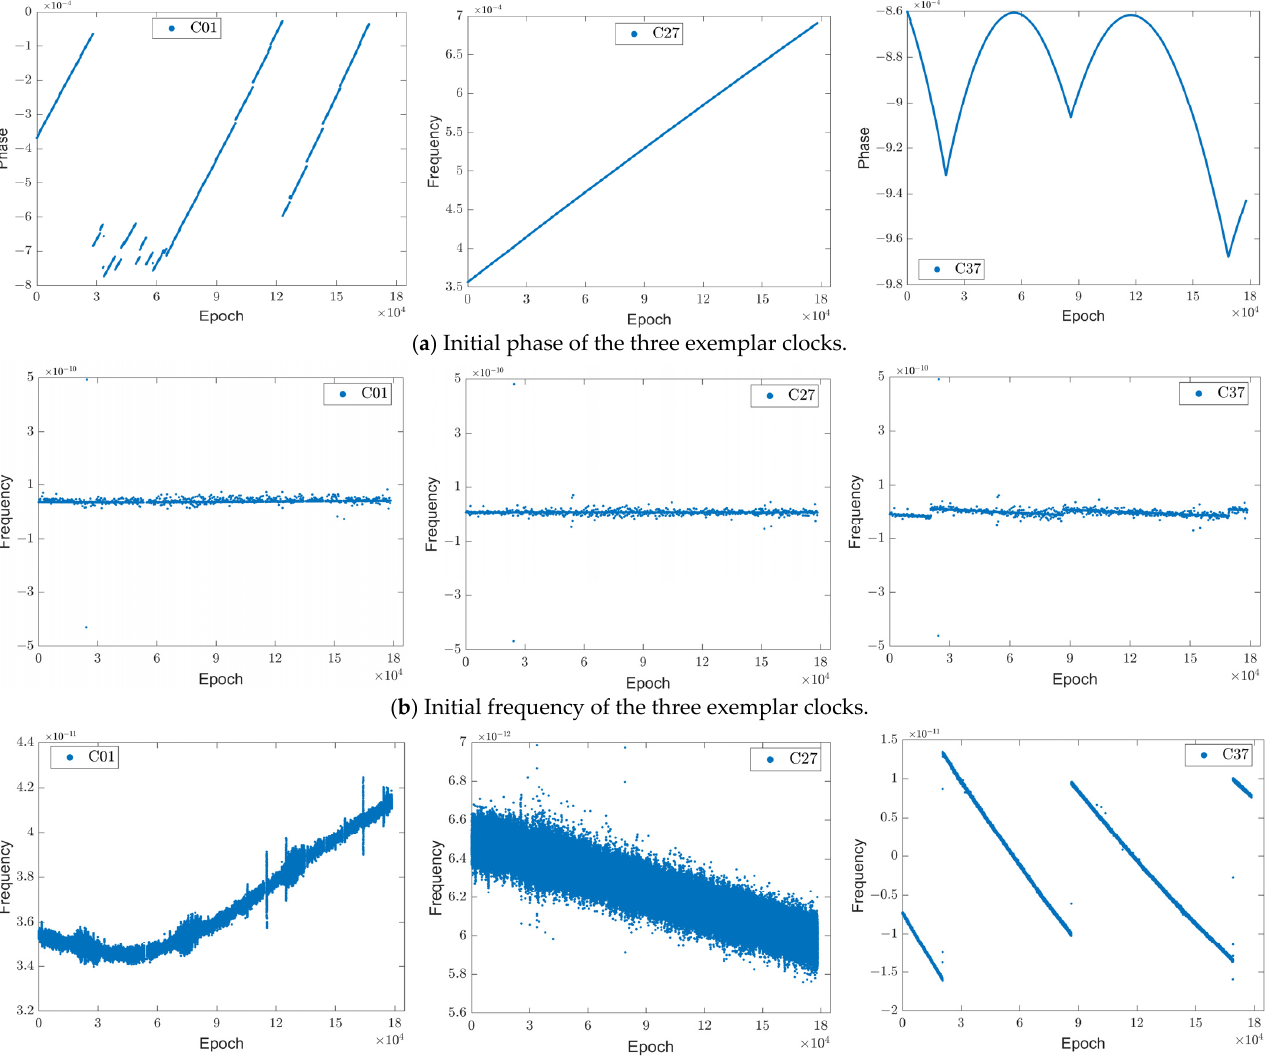
Figure 2. The effect of the outlier detection by MAD.